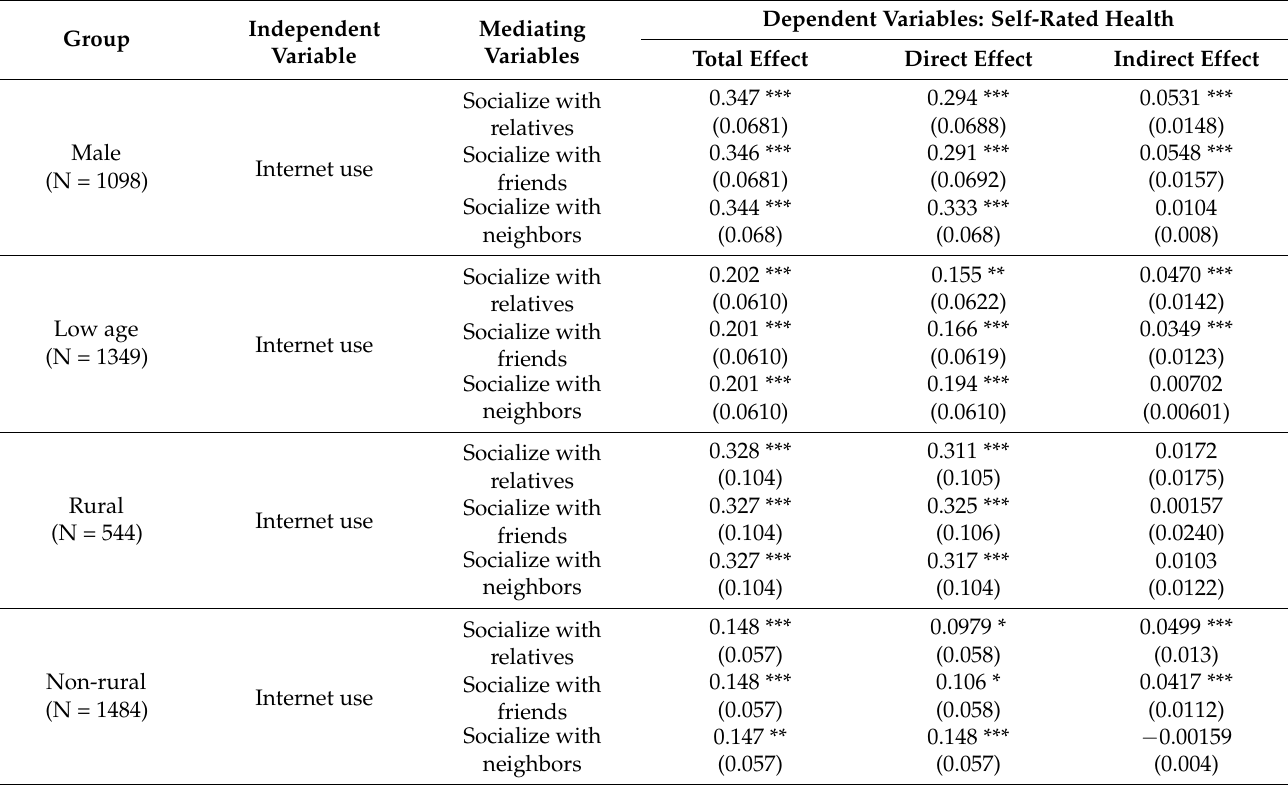
Table 9. Results of heterogeneity analysis. (KHB